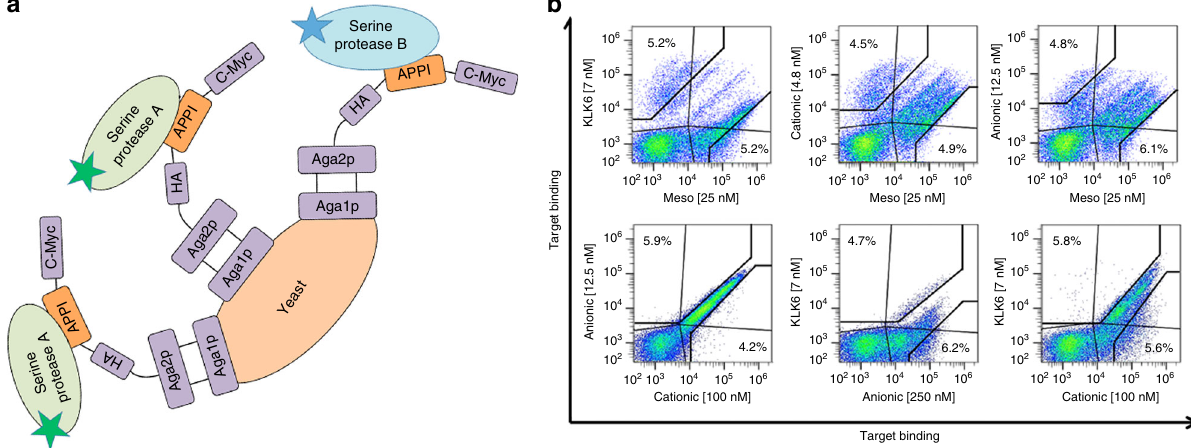
Fig. 1 Yeast-surface display of APPI-3M. a Schematic drawing of the pairwise selective screen using the YSD system. A naive library of mutated APPI-3M variants was displayed on the yeast cell surface and presented to pairs of proteases. Each protease in the pair (denoted A or B) was labeled with a different fl uorescent dye — Alexa Fluor-650 or Alexa Fluor-488 (represented by green and blue stars, respectively). b Pairwise selective screen. Flow cytometry sorting was used to screen the library to isolate APPI-3M variants, with enhanced selectivity toward each of the four serine proteases (Meso: mesotrypsin; KLK6; Anionic: anionic trypsin; Cationic: cationic trypsin). In each sort, two variant populations were collected inside the black gates, yielding sorted library populations of protease-selective APPI-3M variants. Green and blue colors represent a high and low cell densities, population for each individual protease (Supplementary Fig- ure 2), con fi rming selectivity improvements of the sorted library fractions.